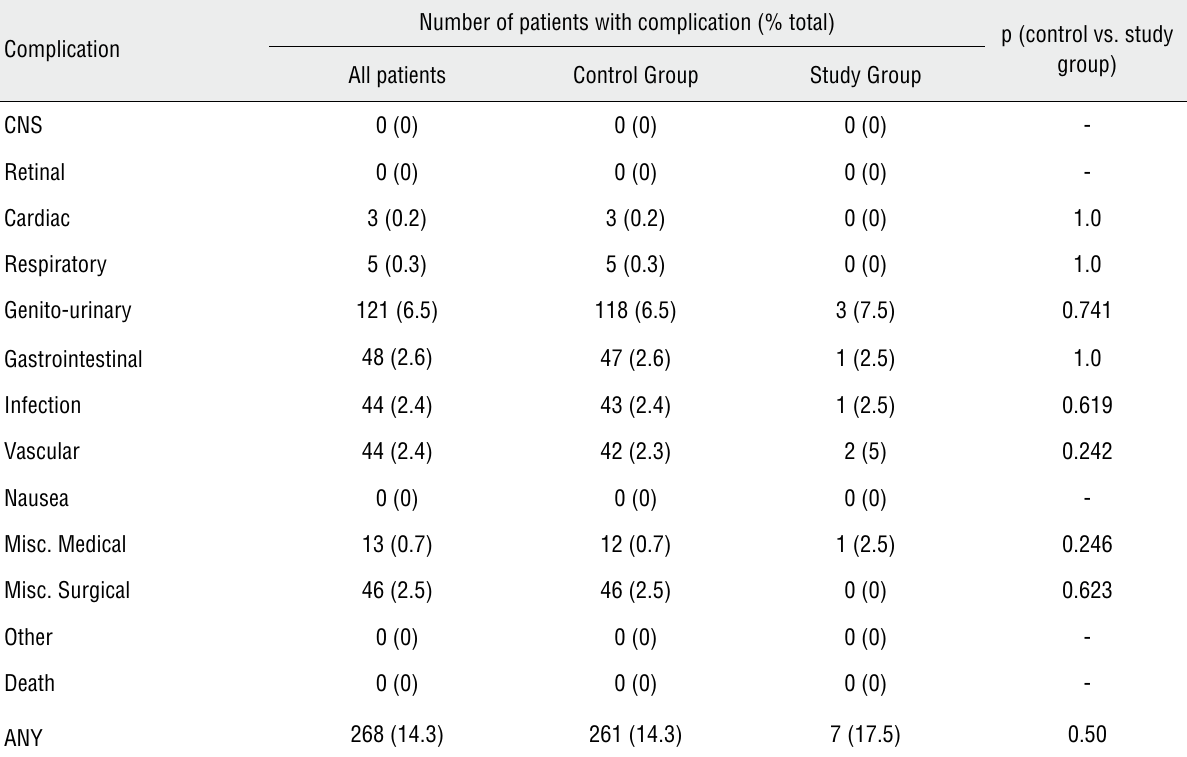
Table 3 - Incidence of complications in patients following RALP